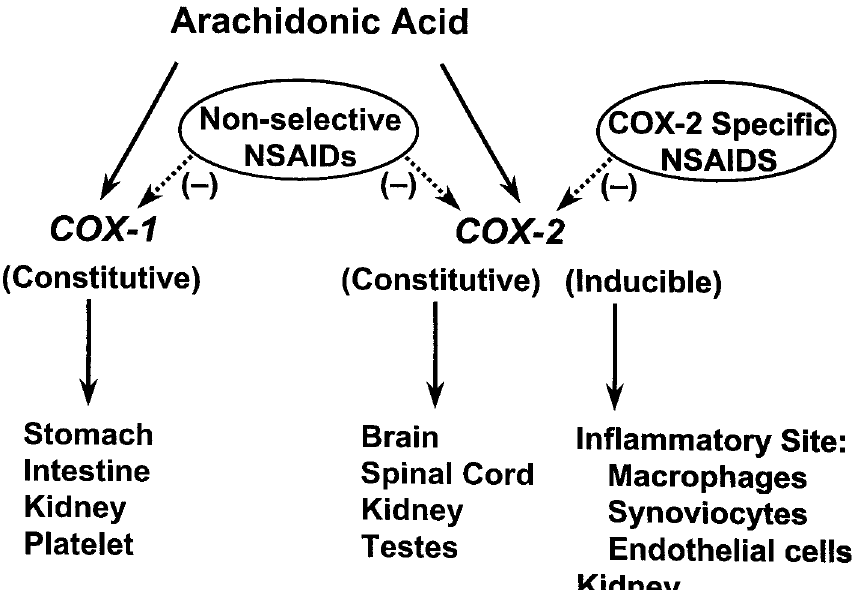
FIG. 2. The tissues where COX-1 and COX-2 are constitutively expressed and COX-2 is inducibly expressed, and where NSAIDs may exhibit clinical effects. The inhibitory actions of non-selective NSAIDs on COX-1 and COX-2, and the inhibitory actions of COX-2-specific NSAIDs on constitutive and inducible COX-2, are schematically